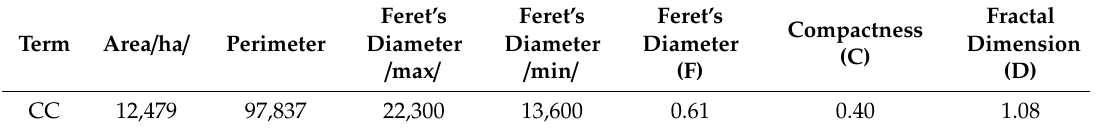
Table 9. Land-use form analysis of the compact city concept